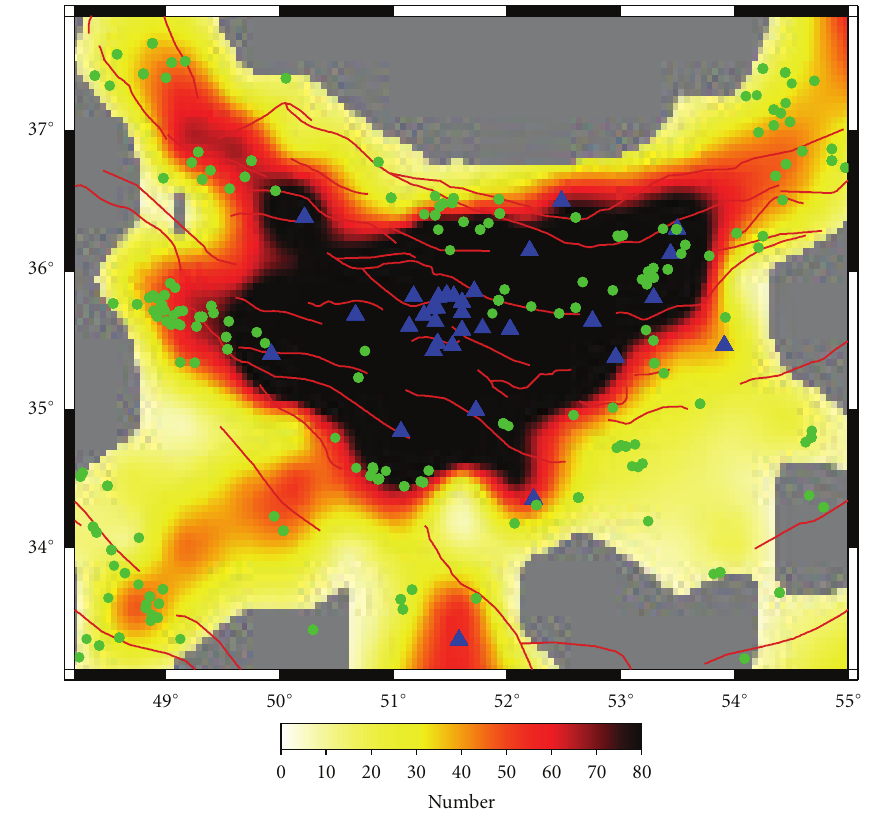
Figure 2: The path-coverage density variation in the study area. Circles and triangles represent earthquake epicenters and seismic stations,